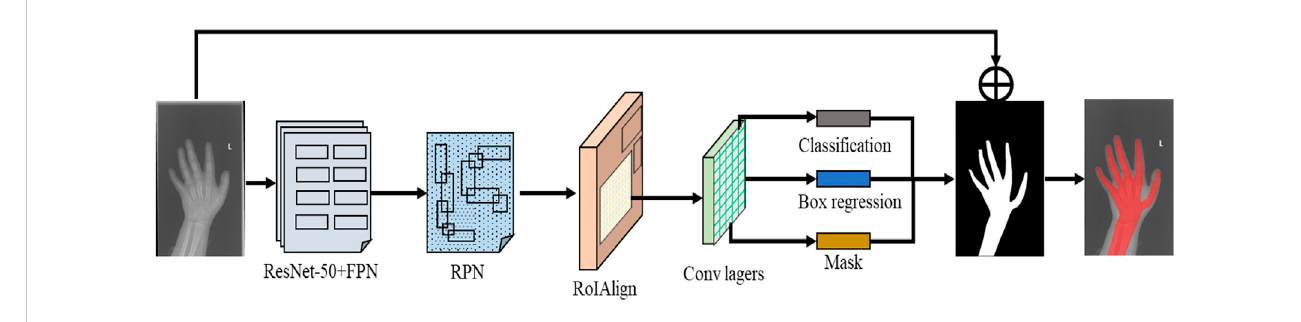
FIGURE 2 Structure of hand bone segmentation